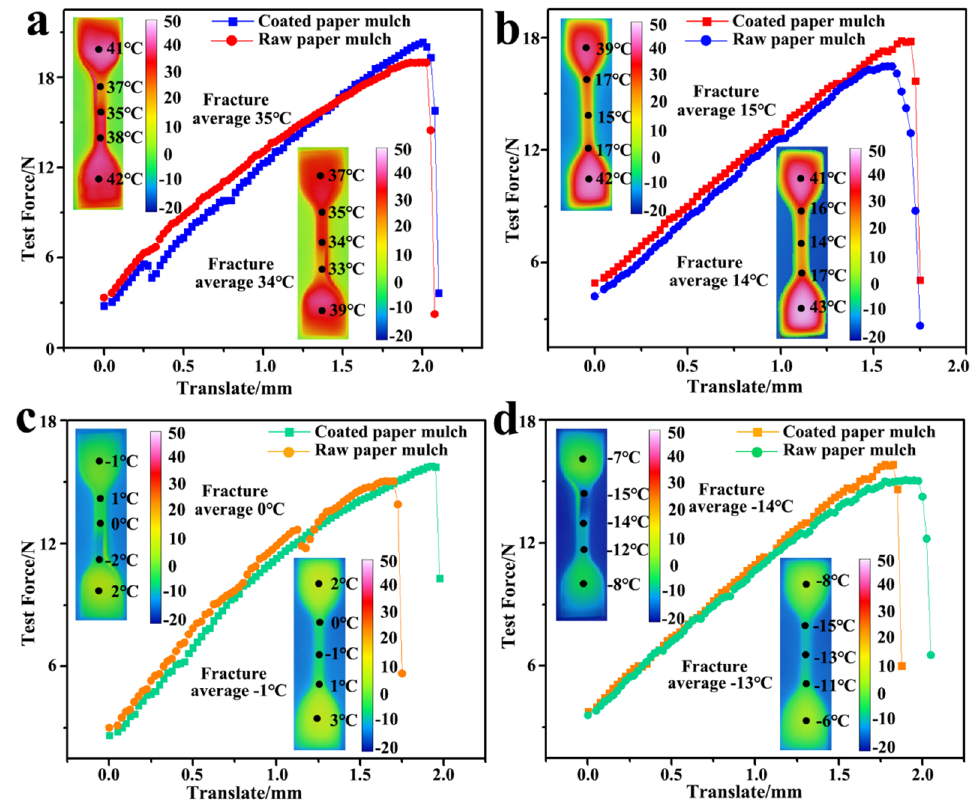
Figure 14. ( a ) High temperature tensile graph, ( b ) Normal temperature tensile graph, ( c ) Low temperature tensile graph, ( d ) Ultra ‐ low temperature tensile graph.